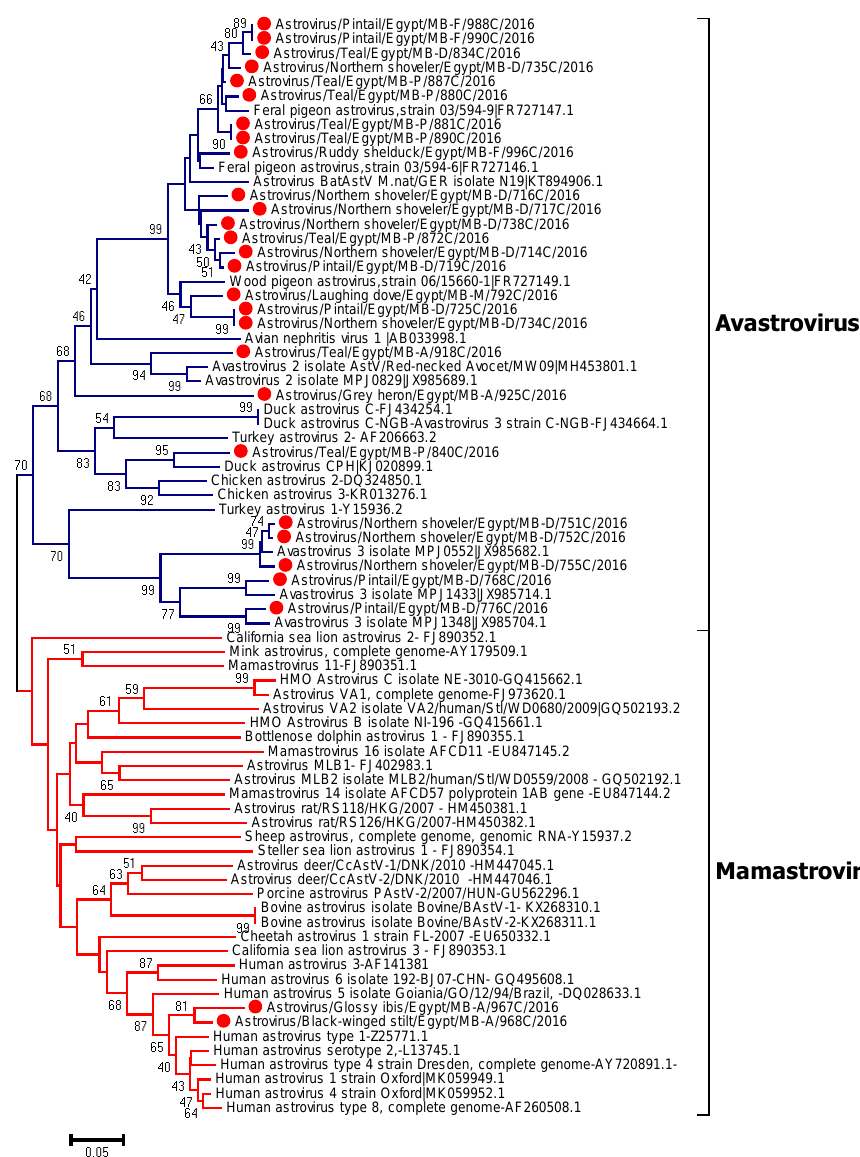
Figure 2. Neighbor joining phylogenetic tree of 342 bp of RNA-dependent RNA polymerase gene of the detected astroviruses in wild bird samples. Geographical sampling location was indicated in taxa of our Avastroviruses as MB-A: Aswan; MB-D: Damietta; MB-P: Port Said; and MB-F: Fayoum. Astroviruses sequenced specifically for this study are labeled with red circles. The percentage of replicate trees in which the associated taxa clustered together in the bootstrap test (1000 replicates) is shown at the dendrogram nodes. The phylogenetic analysis was performed by using MEGA version 7.